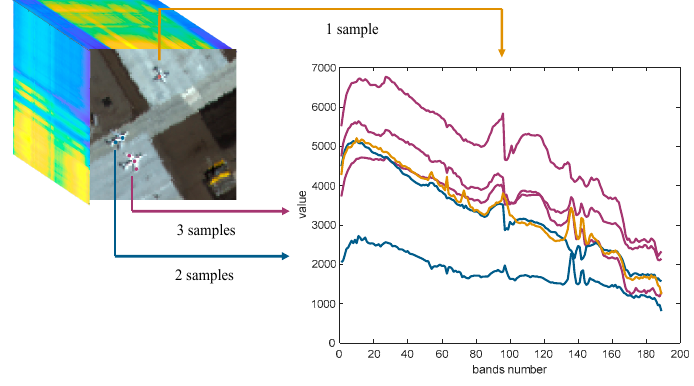
Figure 1. Illustration of spectra variability.